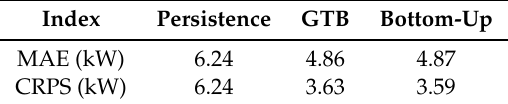
Table 3. Indices of two benchmarking methods and our bottom-up